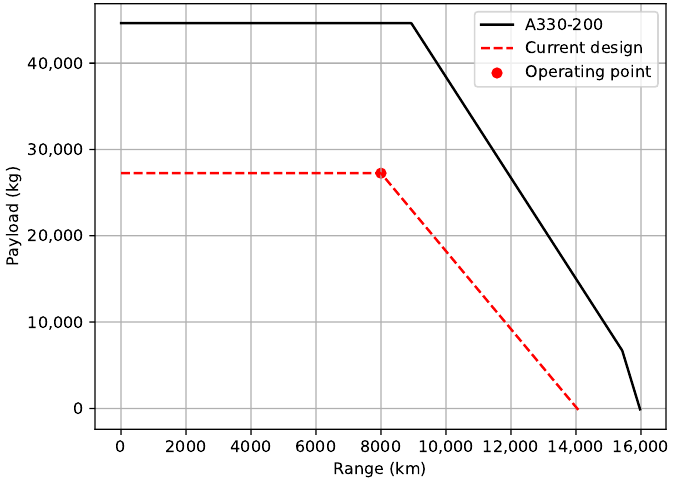
Figure 4. Payload-range diagram of current design and A330-200.